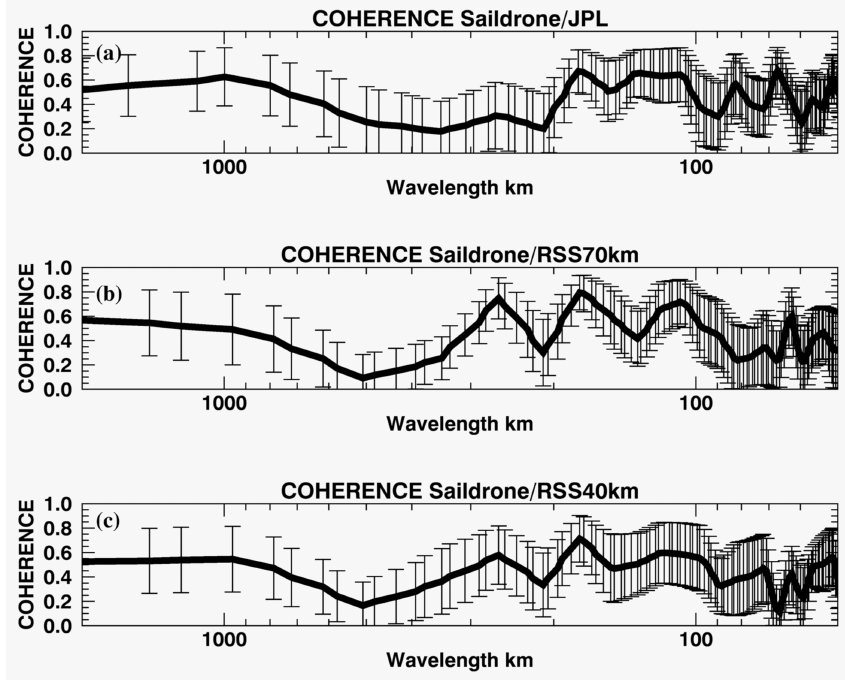
Figure 7. ( a ) Coherence for JPLSSS/Saildrone, ( b ) coherence for RSS40km/Saildrone, and ( c ) coher- ence for